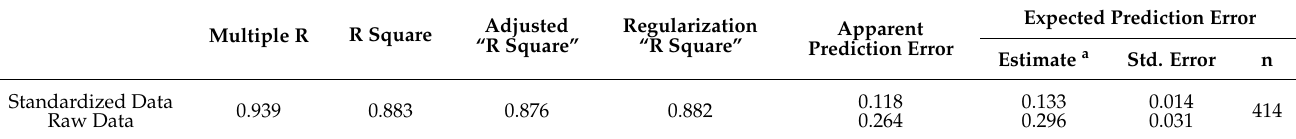
Table 9. Model Summary.